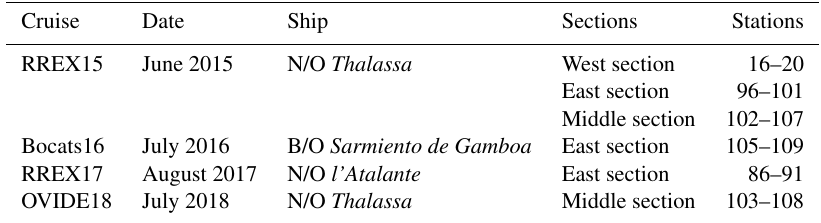
Table 1. Summary of the sections occupied during the four hydrographic cruises and the associated station numbers. Details on the cruises and on the locations of the stations can be found in Branellec and Thierry (2016), Branellec and Lherminier (2017), Branellec and Thierry (2018), and Branellec et al.